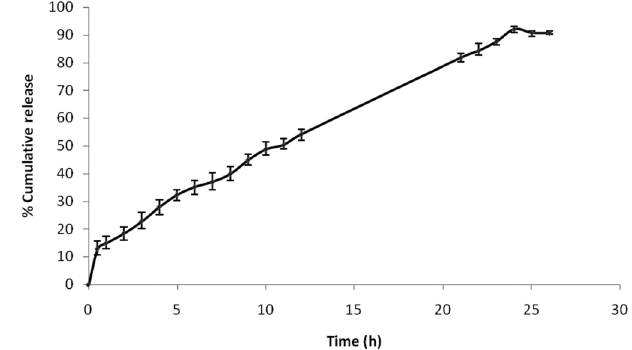
FIGURE 3 - Dissolution profile of sustained release multiparticulate tablet